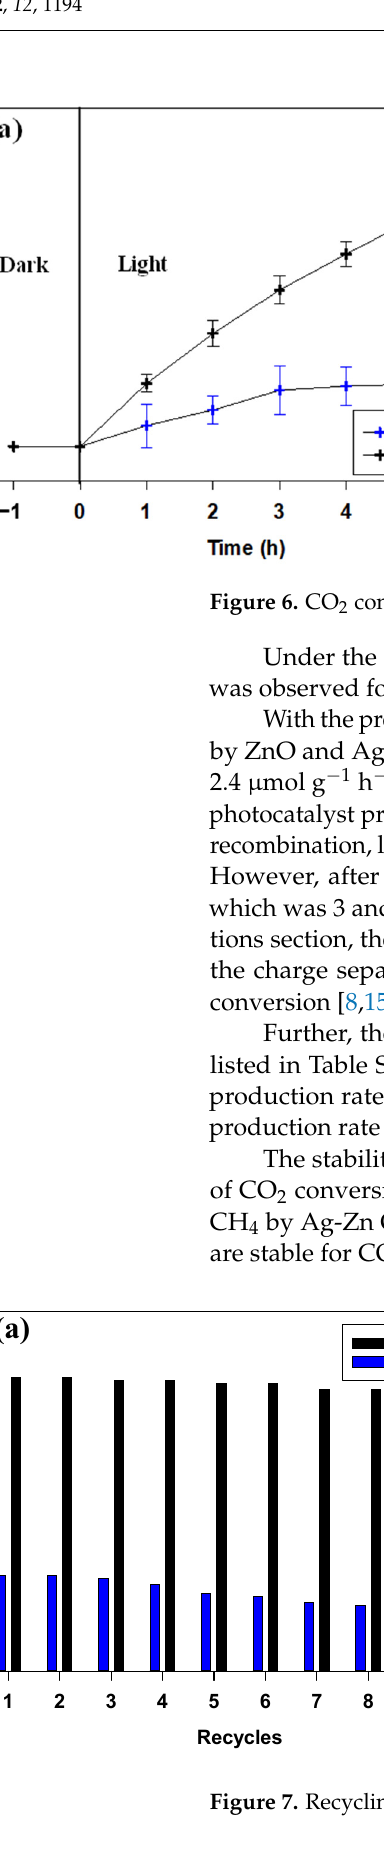
Figure 6 presented the photocatalytic activities of ZnO and Ag-ZnO for CO 2 conver- sion into different products including CO and CH 4 .